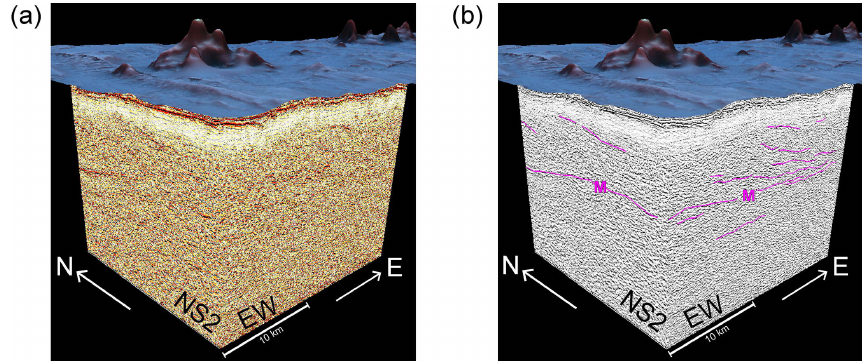
Figure 6. Three-dimensional view from the southwest to the northeast around the OBS2. (a) Prestack time-migrated section. (b) Reflector interpretation. M denotes the Moho